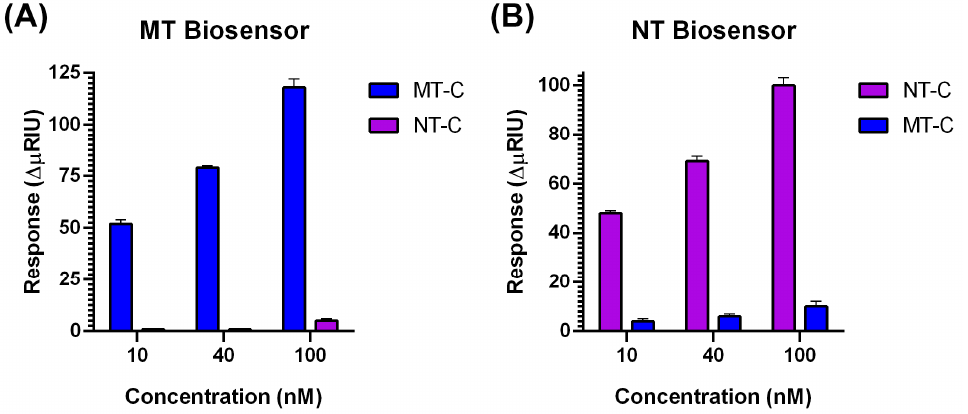
Figure 7. ( A ) Graph of the response of complementary (MT-C) versus noncomplementary strands (NT-C) in the MT biosensor and ( B ) graph of the response of complementary (NT-C) versus noncomplementary strands (MT-C) in the NT biosensor. The concentrations studied were 10, 40, and 100 nM, with n =